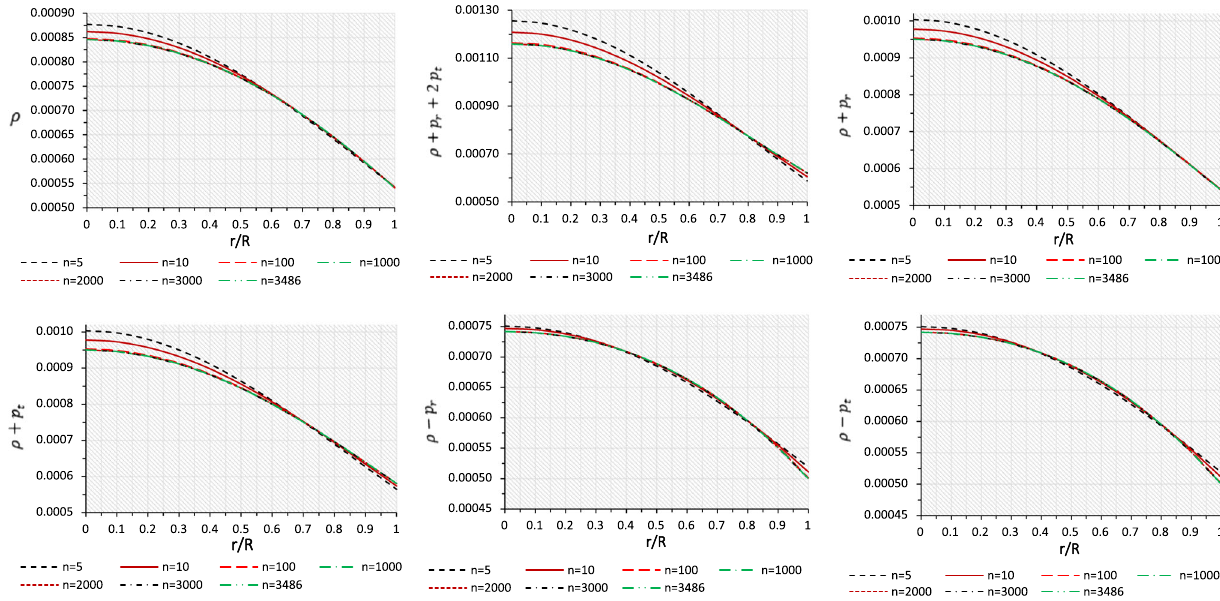
Fig. 6 Behaviour of energy conditions vs. radial coordinate r / R with different values of n for LMC X −